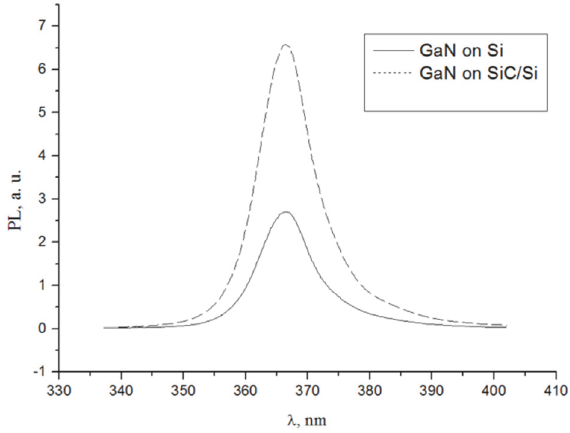
Figure 4: Typical RT PL spectra of GaN NWs grown on SiC/Si substrate and the most successful GaN structure grown on silicon.